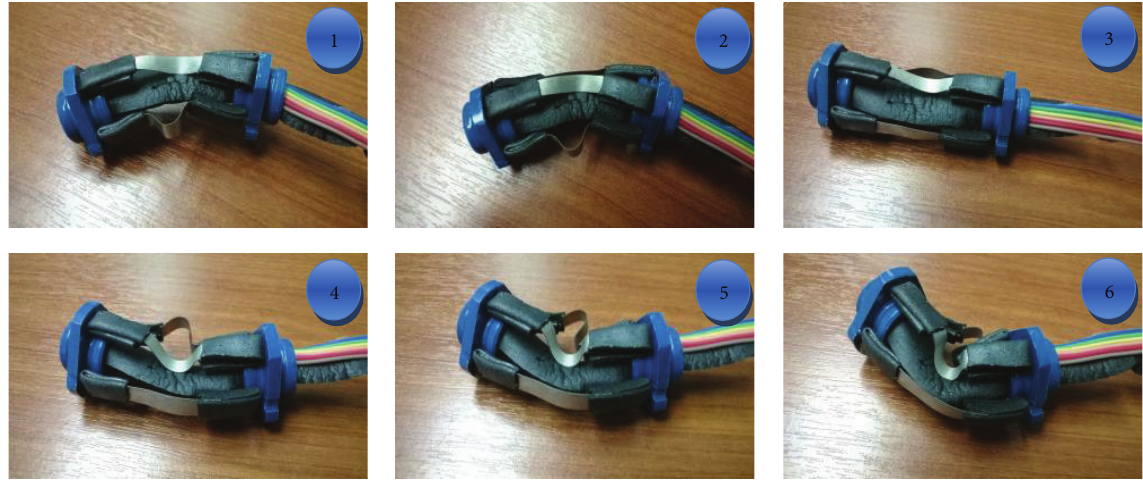
Figure 13: Prototype presents the actual process of actuator